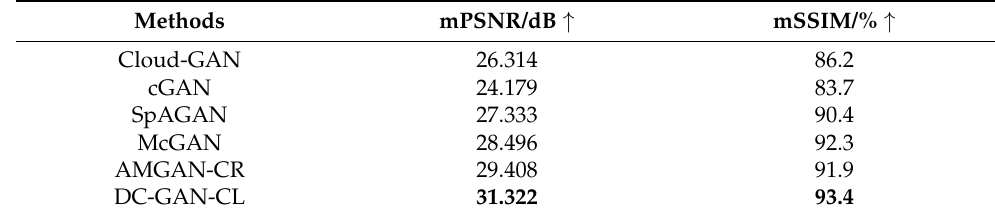
Table 3. Quantitative evaluation of various methods on the RICE2 test